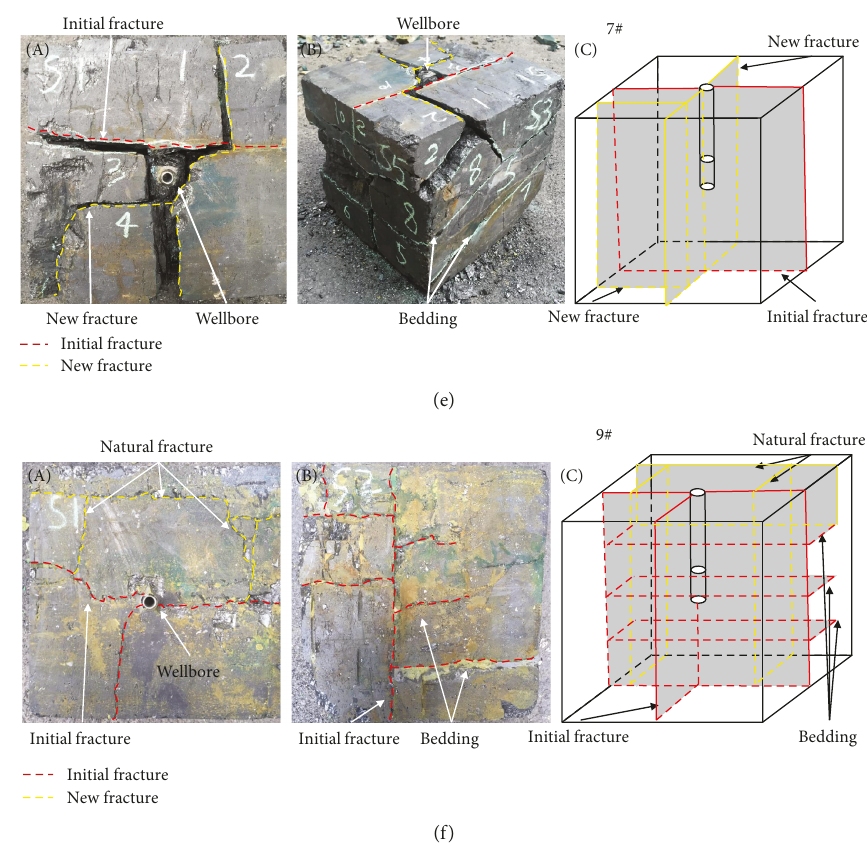
Figure 5: Experimental results of fracture geometry after